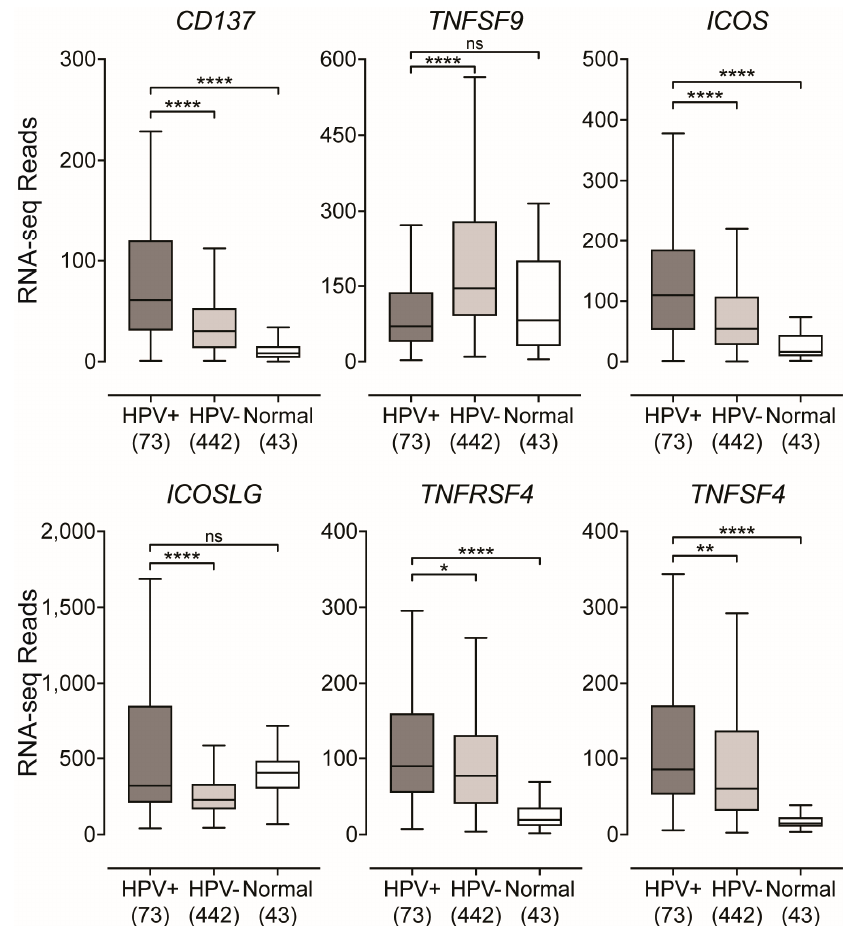
Figure 6. Expression of inducible T-cell survival signal molecules in head and neck carcinomas stratified by HPV-status. RSEM normalized RNA-seq data for inducible genes that encode for T-cell survival molecules was extracted from the TCGA database for the HNSC cohort for HPV+, HPV − , and normal control tissues. Statistical analysis was performed using a two-tailed non-parametric Mann–Whitney U test. Numbers in brackets refer to the number of samples included in each analysis. * p ≤ 0.05, ** p ≤ 0.01, *** p ≤ 0.001, **** p ≤ 0.0001, ns—not